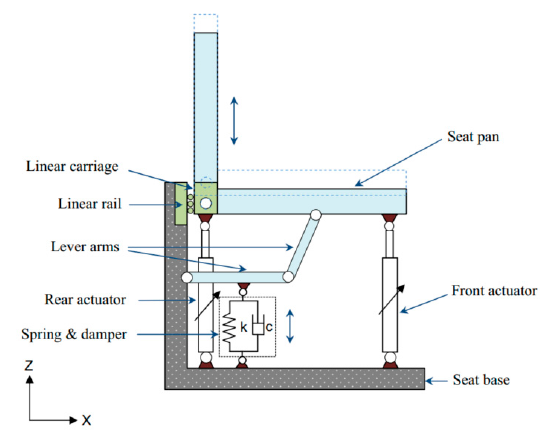
Figure 16. The model of the active seating system [63].